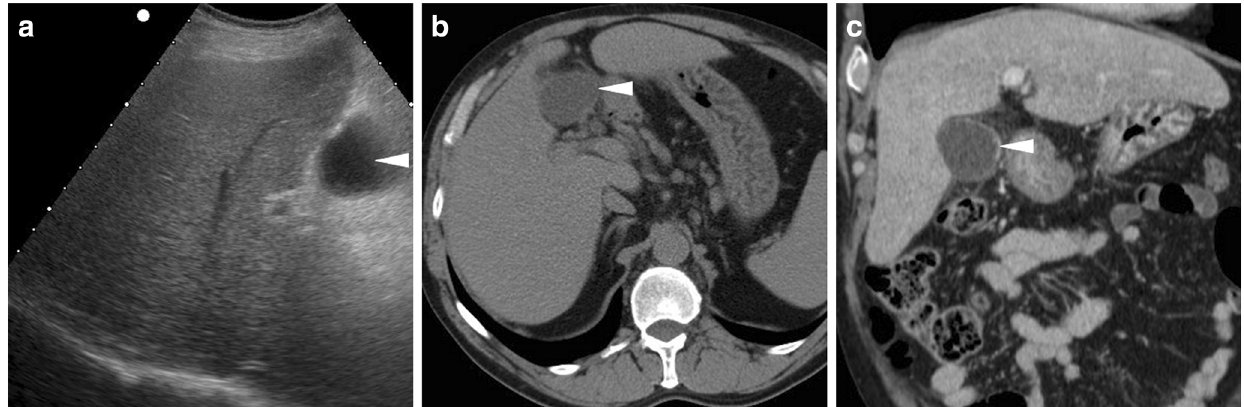
Fig. 6 Mimicking a postoperative collection, a fluid-containing structure ( arrowheads ) with thin walls is seen 2 months after surgery in the oper- ated gallbladder fossa at both ultrasound ( a ) as well as precontrast ( b ) and